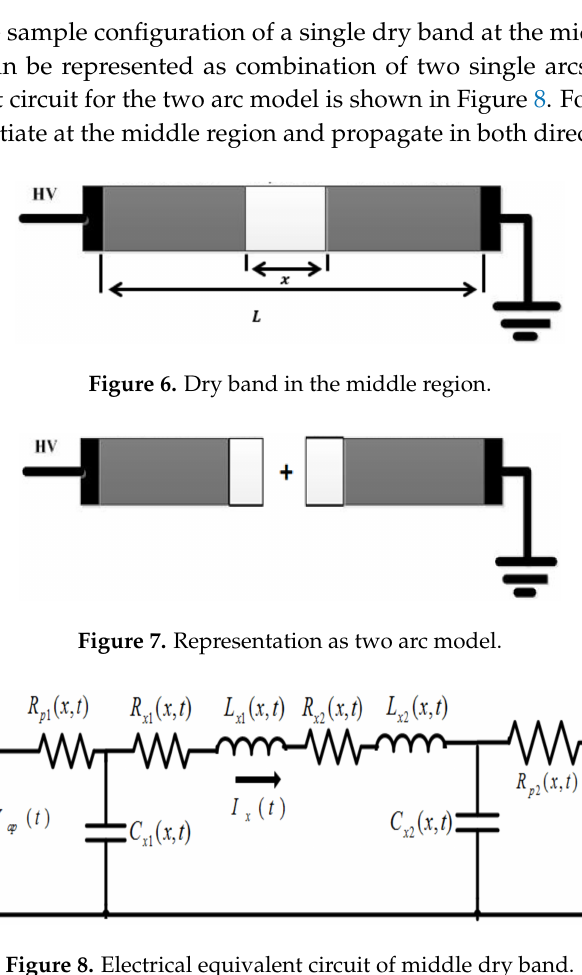
Figure 8. Electrical equivalent circuit of middle dry